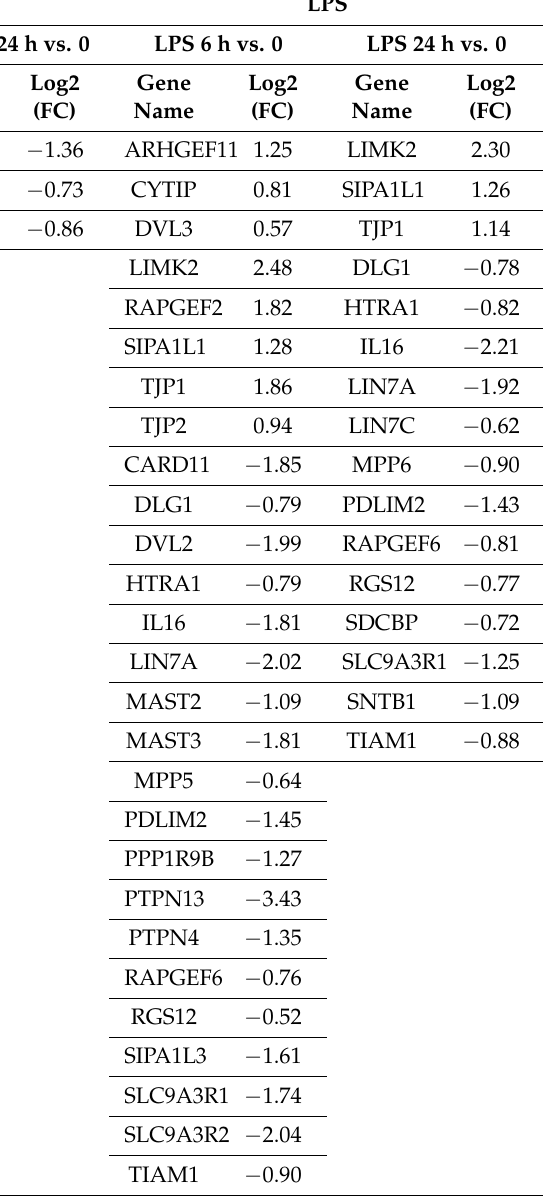
Table 1. PDZ DEGs in M φ stimulated with HKMtb or LPS. Gene expression level (log2 mean fold change) subjected to one-way ANOVA with a Dunnett’s test. Statistical significance was set at p < 0.05. M φ